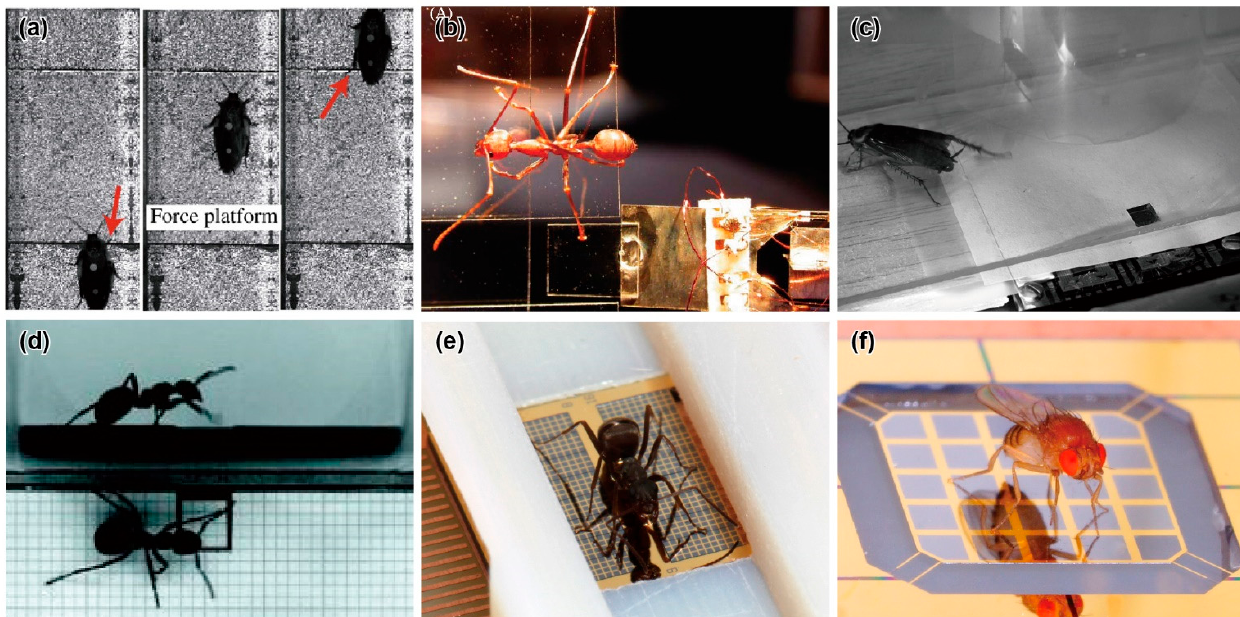
Figure 2. Photographs of insects located on specially fabricated force plates. ( a ) Climbing cockroach on a force plate. Reprinted/adapted with permission from [65]. 2022, Company of Biologists ltd. ( b ) Weaver ant on a vertical transparent force plate [72]. ( c ) Running cockroach on a MEMS force plate. Reprinted/adapted with permission from [24]. 2022, IEEE. ( d ) Wood ant on a 3D-printed force plate. Reprinted/adapted with permission from [76]. 2022, Company of Biologists Ltd. ( e ) Running ant on